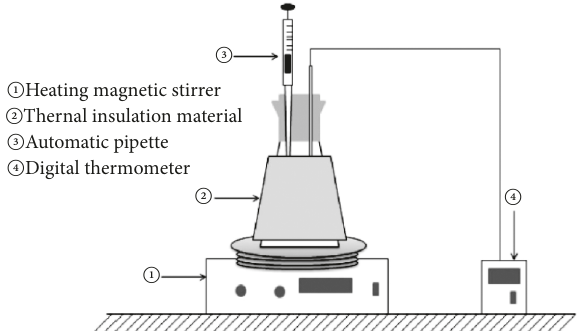
Figure 1: Schematic diagram of the batch adsorption